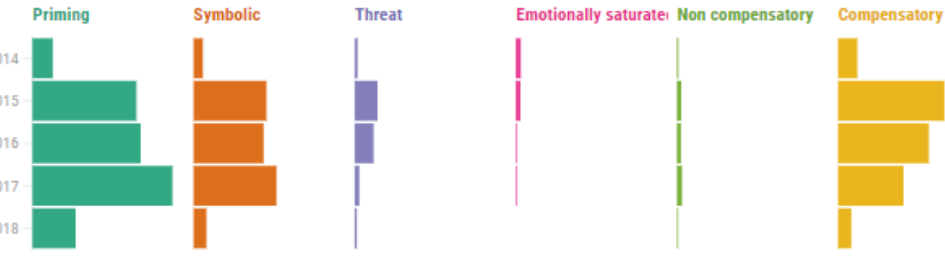
Figure 3: Use of Framing According to the Typology of Mintz and De Rouen (2010) (Source: Authors‟ depiction based on the registry of publications on the websites of both media) The marked predominance of storytelling with legal arguments over the emotional connotation was recorded in all the years covered. These may be observed in Figure 4.